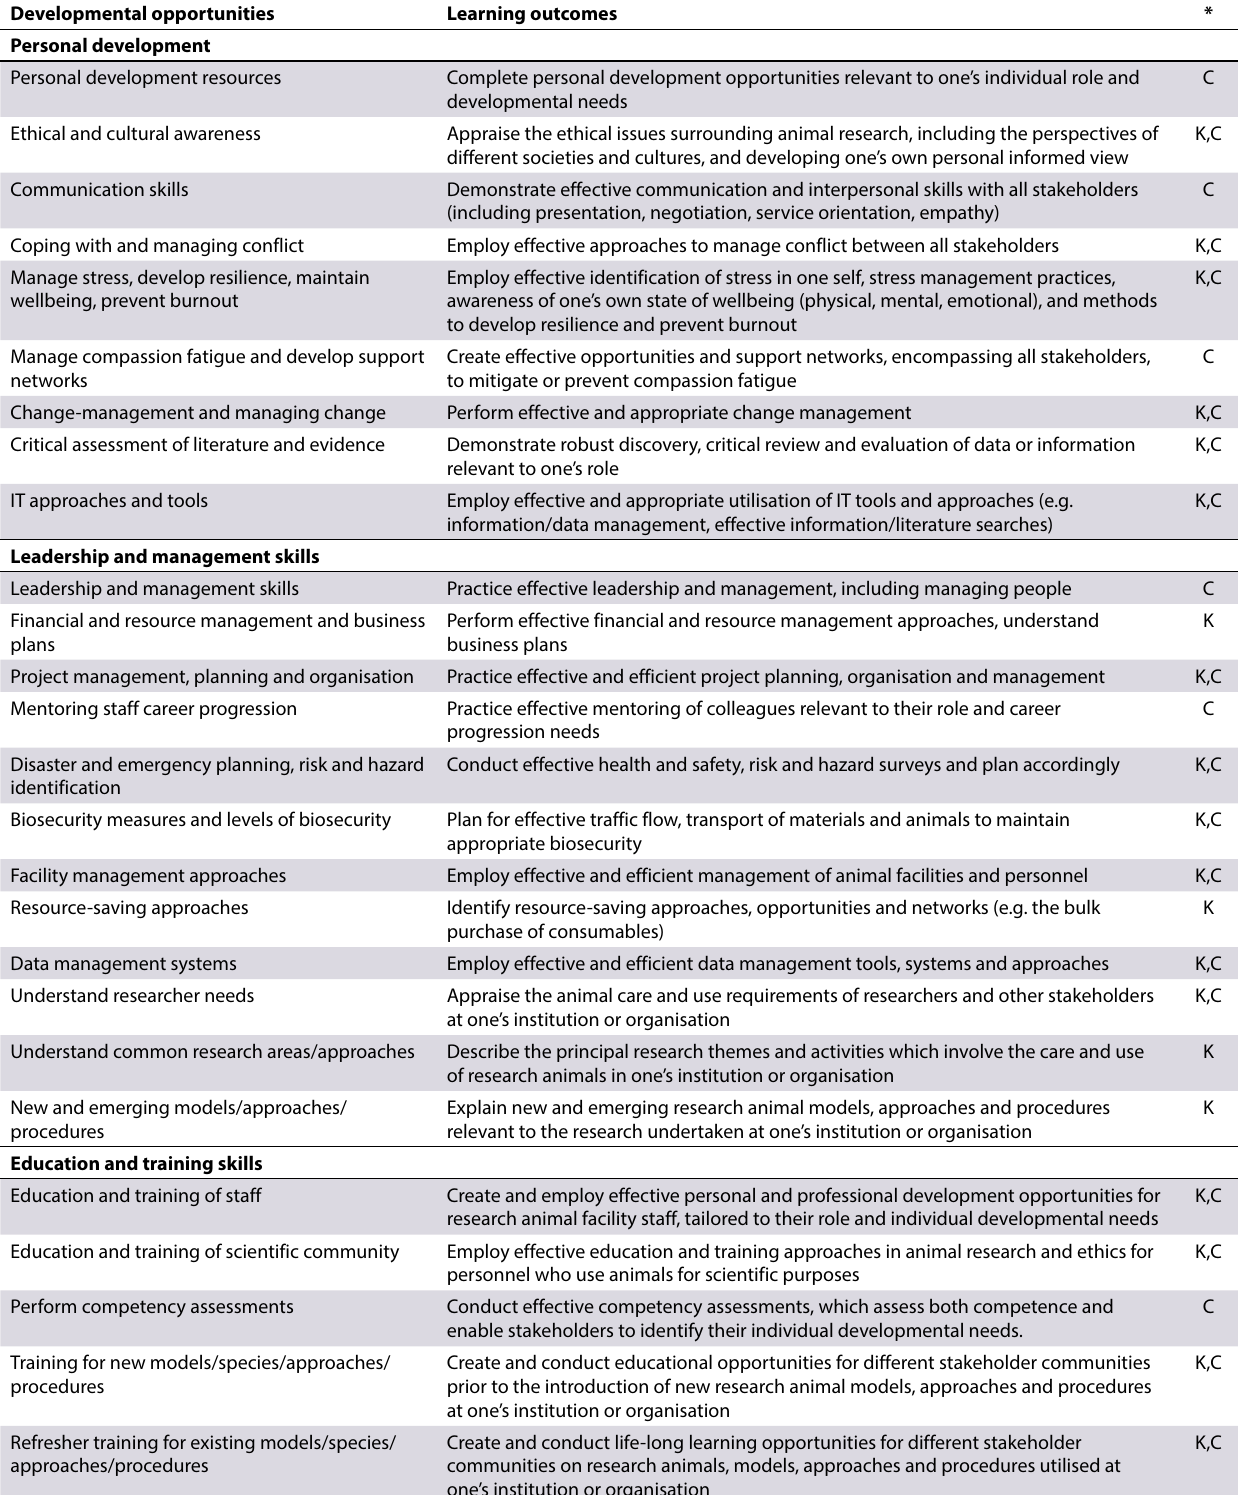
Table II: Learning outcomes for the life-long learning needs of veterinary and para-veterinary professionals in the animal research sector in South Africa (2022 workshop results), identifying five overarching themes for life-long learning Developmental